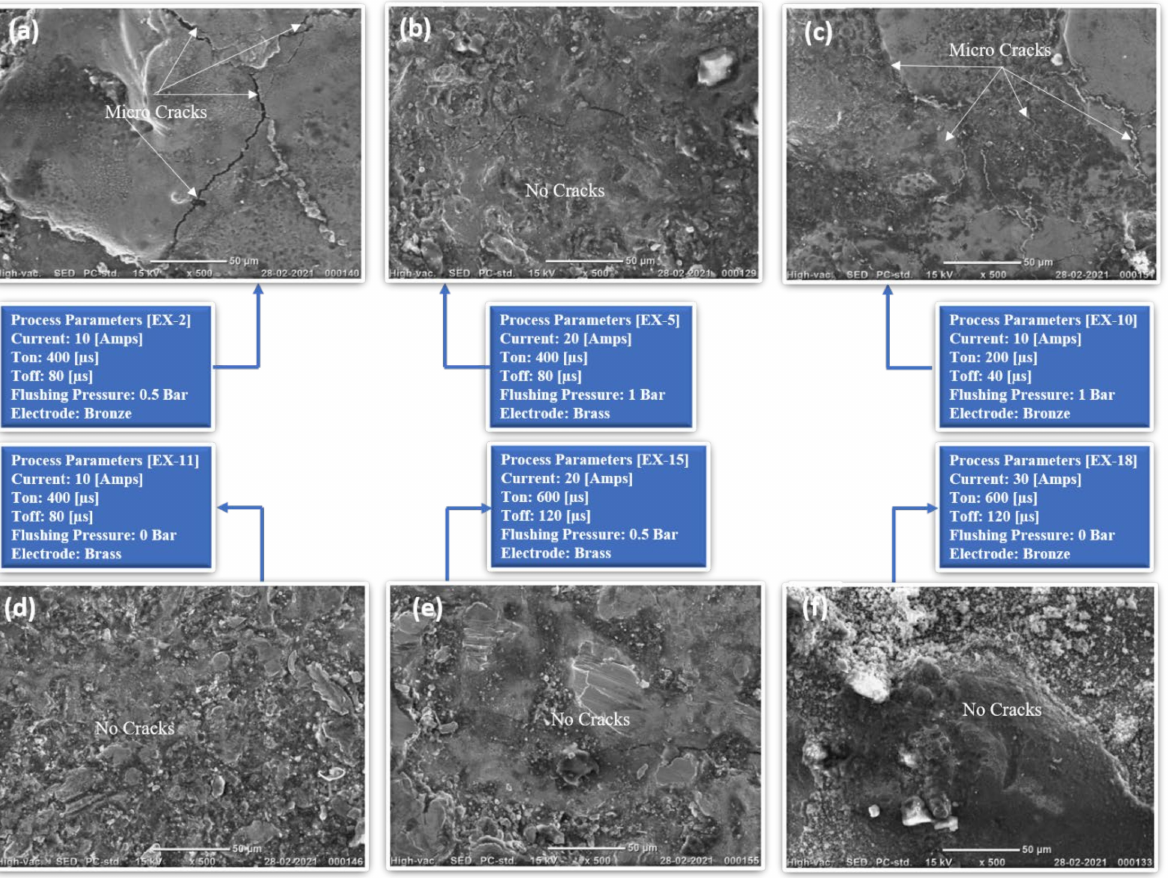
Figure 4. EDC Surface Microcracks: ( a ) EX 2, ( b ) EX 5, ( c ) EXP 10, ( d ) EX 11, ( e ) EX 15 and ( f ) EX 18 (all SEM images are 500 ×